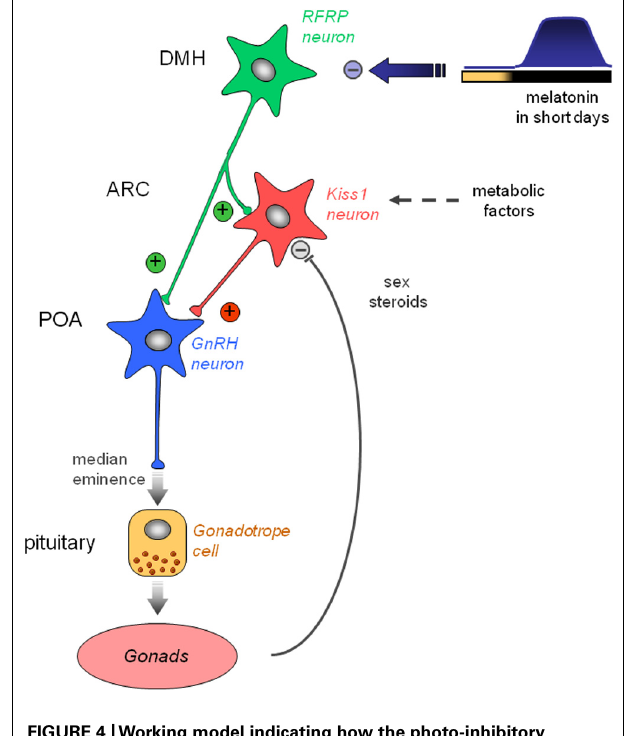
FIGURE 4 |Working model indicating how the photo-inhibitory melatonin message in short day conditions in integrated in the hypothalamus to further regulate the gonadotropic axis of the male Syrian hamster. In long day conditions, RFRP-3 activates GnRH neuron activity directly in the preoptic area (POA) and/or indirectly via the kisspeptinergic neurons in the arcuate nucleus (ARC). In short day conditions, the large production of melatonin inhibits RFRP expression in the dorsomedial hypothalamus, which in turn decreases gonadotropic activity. Kiss1 expression in the ARC is reduced in short day conditions, but it is also inhibited by the testosterone feedback and may be regulated by metabolic